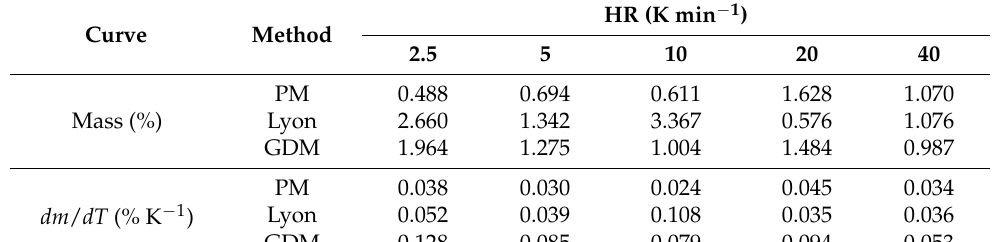
Table 3. Mean absolute error in experimental versus calculated mass- T and dm / dT-T results for PA